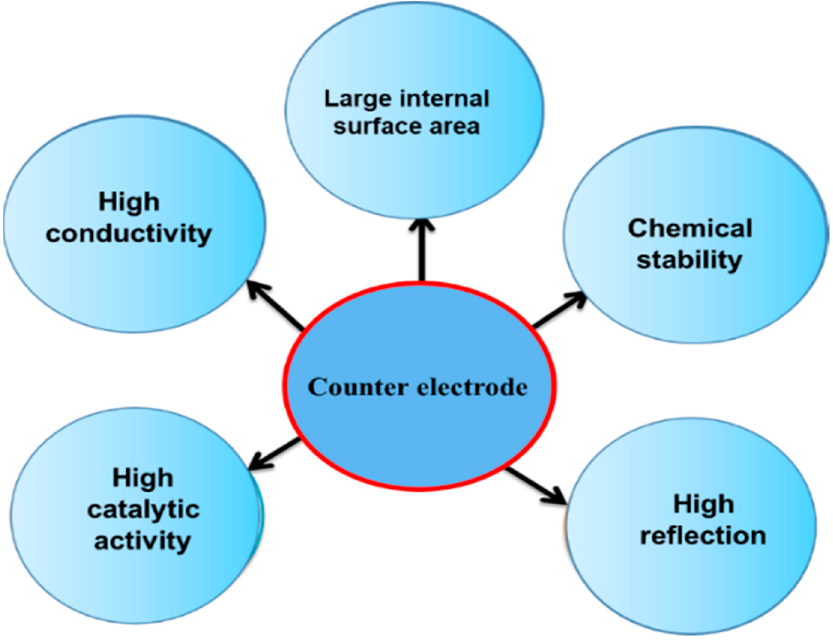
Figure 3. Properties required for high-performance counter electrodes.